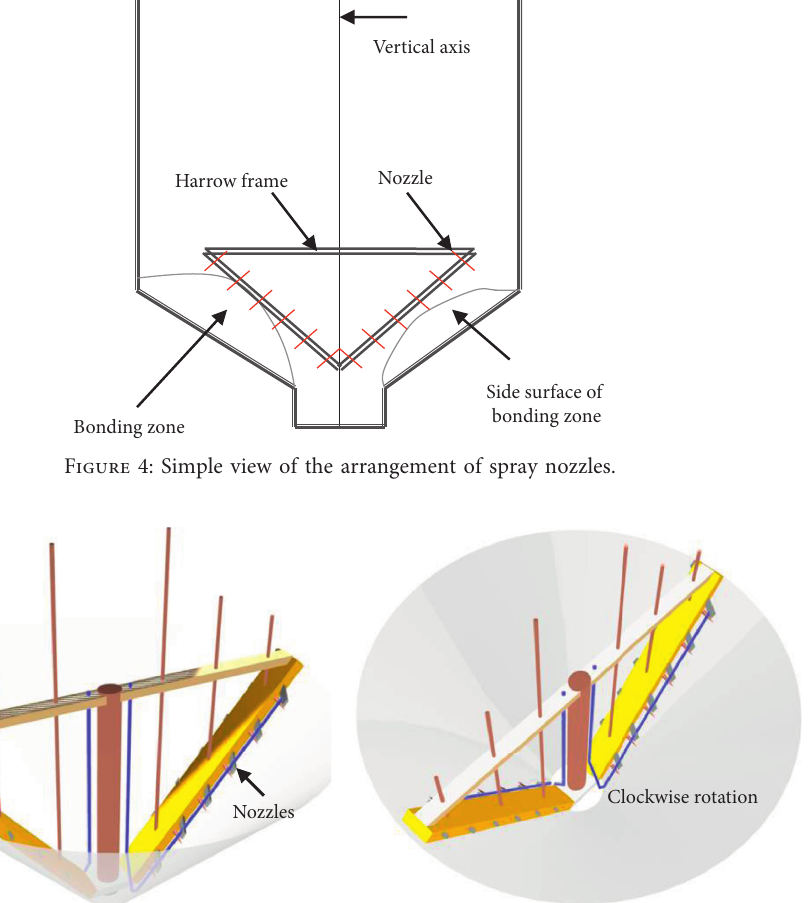
Figure 5: Transformation in the middle of the system and rotation direction of the vertical